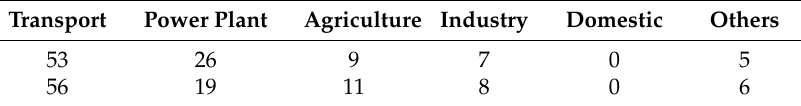
Table 2. Diesel consumption by various sectors (2015–2016).